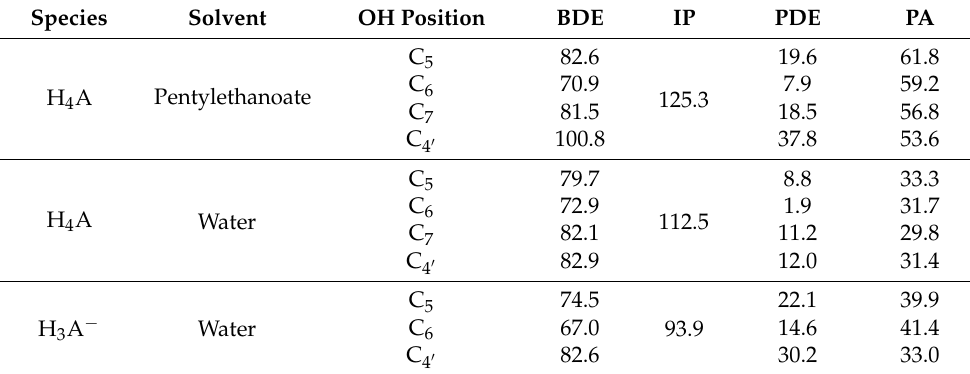
Table 1. Computed BDE, IP, PDE and PA for neutral and charged species in water and pentylethanoate solvents. All values are in